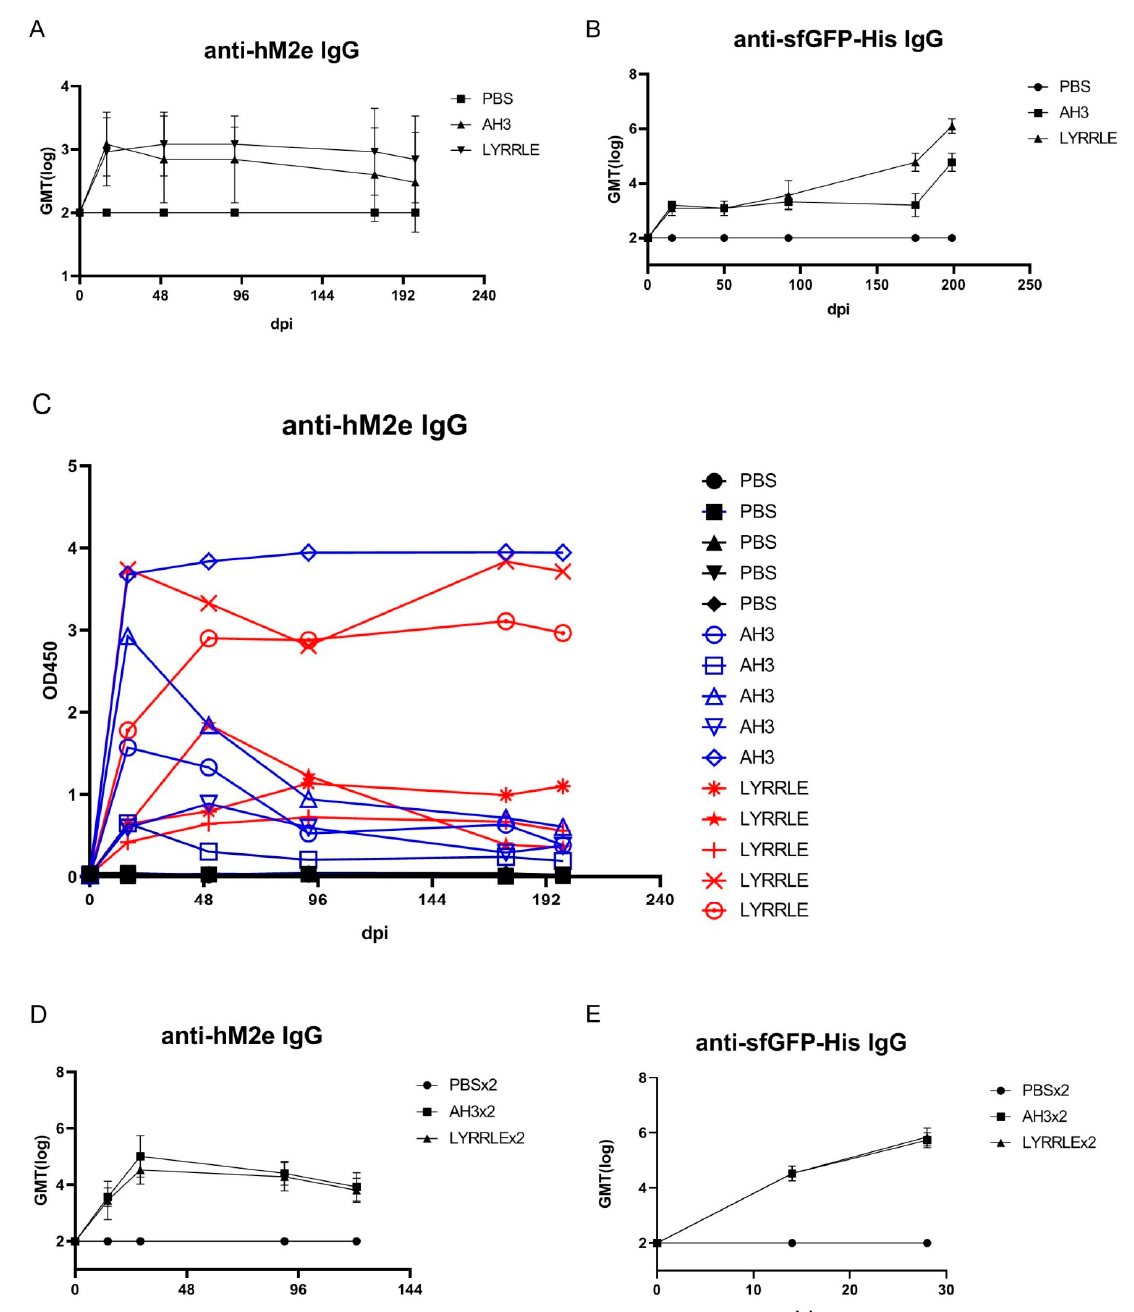
Figure 6. Immunization of mice with AH3–sfGFP–2xhM2e and LYRRLE–sfGFP–2xhM2e and detec- tion of anti-hM2e IgG and anti-sfGFP IgG. The mice were immunized once at day 0 with 20 µ g of purified protein nanoparticles assembled by the wild-type AH3 peptide, or the LYRRLE mutant, or PBS. Sera were collected at days 0, 16, 50, 91, 175, and 199 for analysis to detect ( A ) total anti-hM2e IgG and ( B ) total anti-sfGFP IgG by ELISA. ( C ) Anti-hM2e total IgG titers are presented as optical densities at OD450 using immune serum from each mouse diluted 1:100. ( D ) The anti-hM2e total IgG of mice immunized twice, 14 days apart, in a prime-boost regime was followed for 3 months and analyzed by ELISA (N = 5). ( E ) The anti-sfGFP–His total IgG of mice immunized twice with AH3–sfGFP–2xhM2e or LYRRLE–sfGFP–2xhM2e were evaluated 14 days after each immunization by ELISA (N =